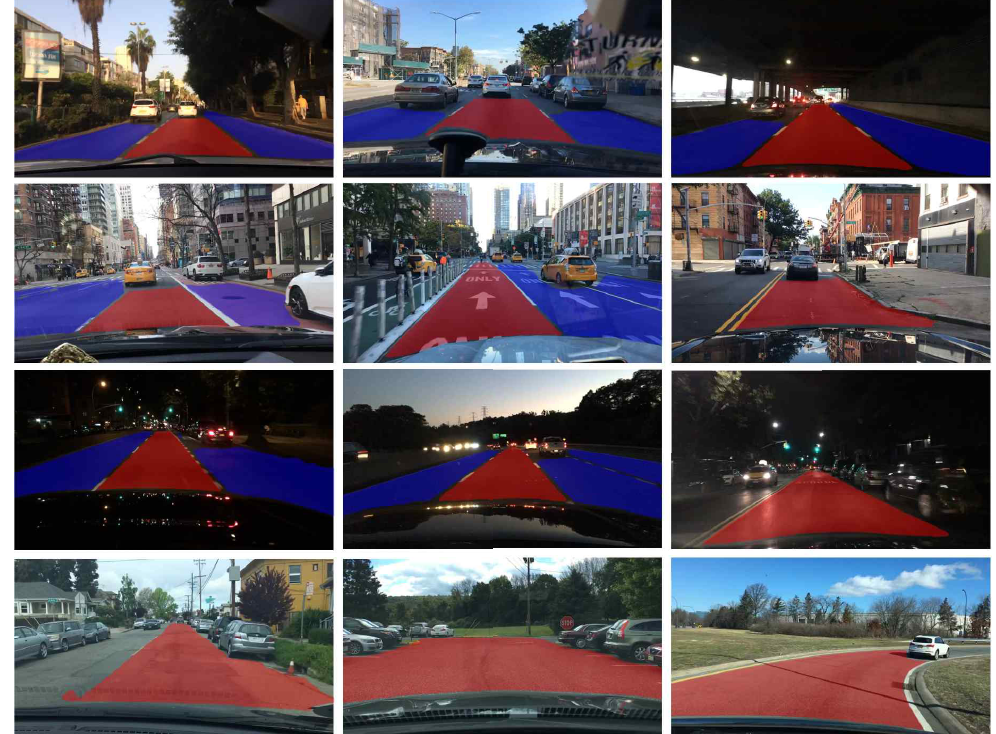
Figure 4. Visualization of drivable area detection result. The red area corresponds to the ego-lane and blue area indicates the alternative drivable area.